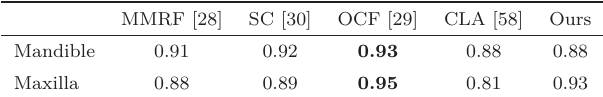
Table 6 Comparison on supervoxel-wise correspondence by forest- based